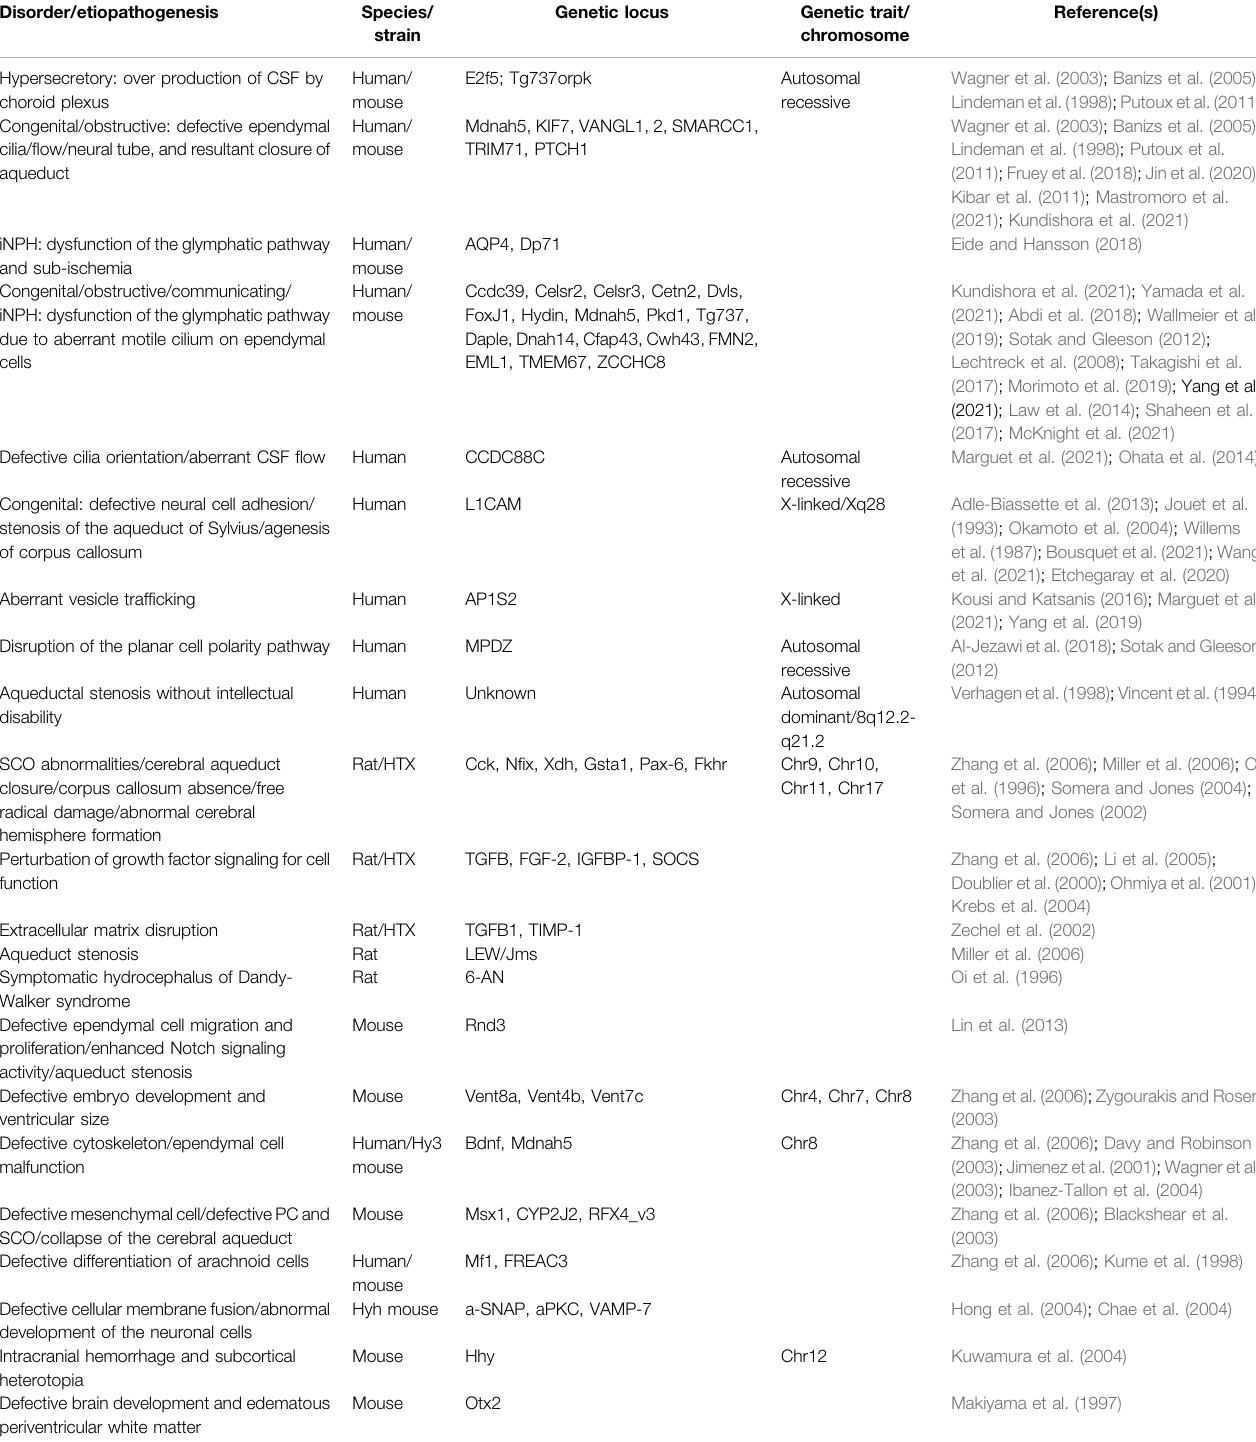
TABLE 2 | Summary of genetic mechanism in the pathogenesis of